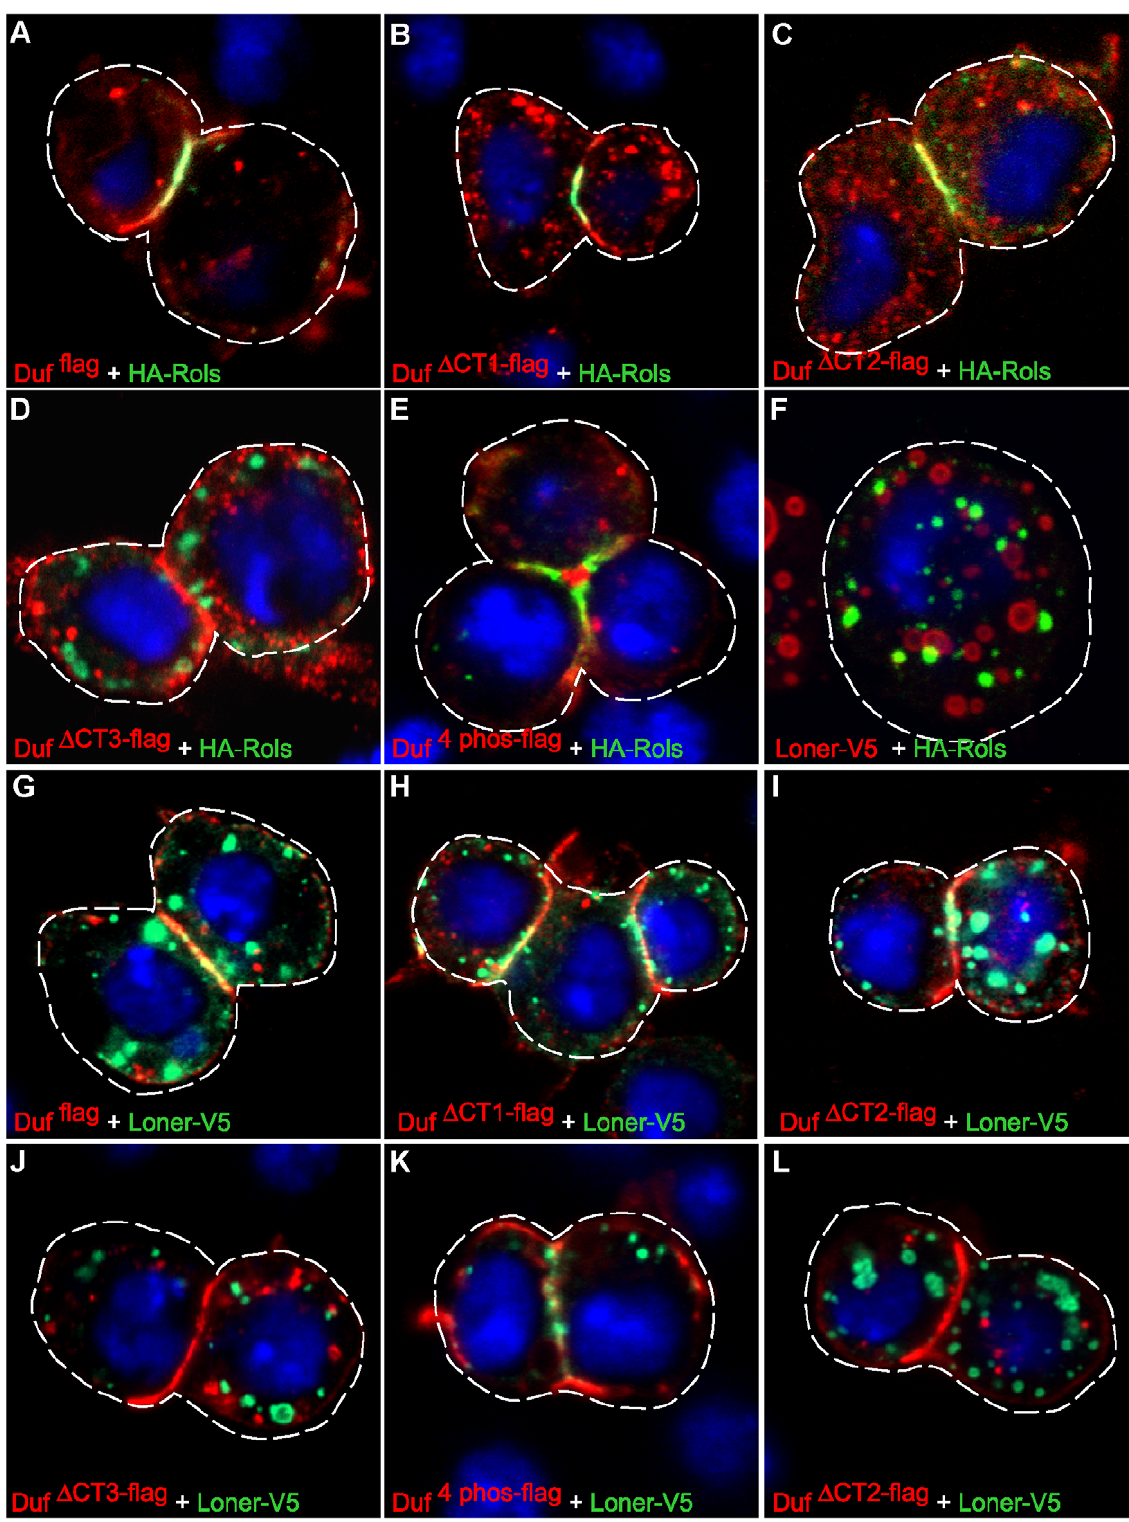
Figure 2. Region between amino acids 687 and 830 is important for translocation of Rols and Loner under homotypic conditions. S2 cells were co transfected with Flag tagged wild type and mutant Duf, detected with anti-Flag (red) and HA-Rols detected with anti-HA (green) (A–E) or Loner-V5 detected with anti V5 (green) (G–L). Wild type Duf flag and Duf D CT1-flag translocate both Rols (A and B) and Loner (G and H) to points of cell contact. Duf D CT2-flag and Duf 4phos-flag translocate Rols (C and E) but Loner only 70% of the time (I and K). 30% of the time they are unable to translocate Loner to points of contact (compare I and L). Duf D CT3-flag is unable to translocate Rols (D) and Loner (J). Rols and Loner puncta do not colocalise (F). Dashed lines indicate cell outlines.